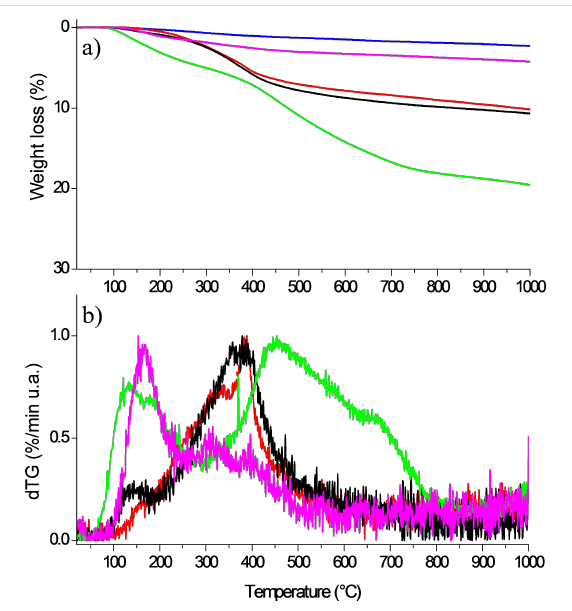
Figure 3: TGA weight loss under helium of raw SWNTs (blue curve), phys-SWNT (violet curve), f-SWNT-5min (red curve), f-SWNT-10min (black curve), and f-SWNT-15min (green